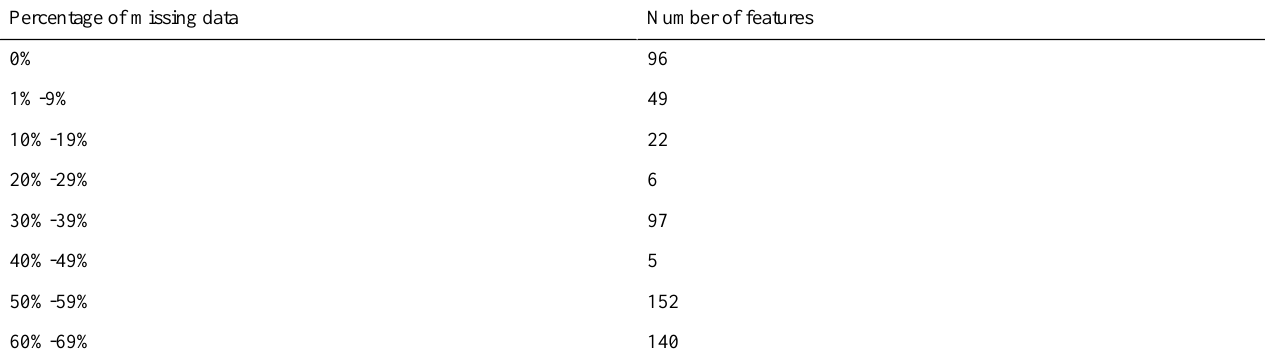
Table 1. Statistics of the features with missing data.